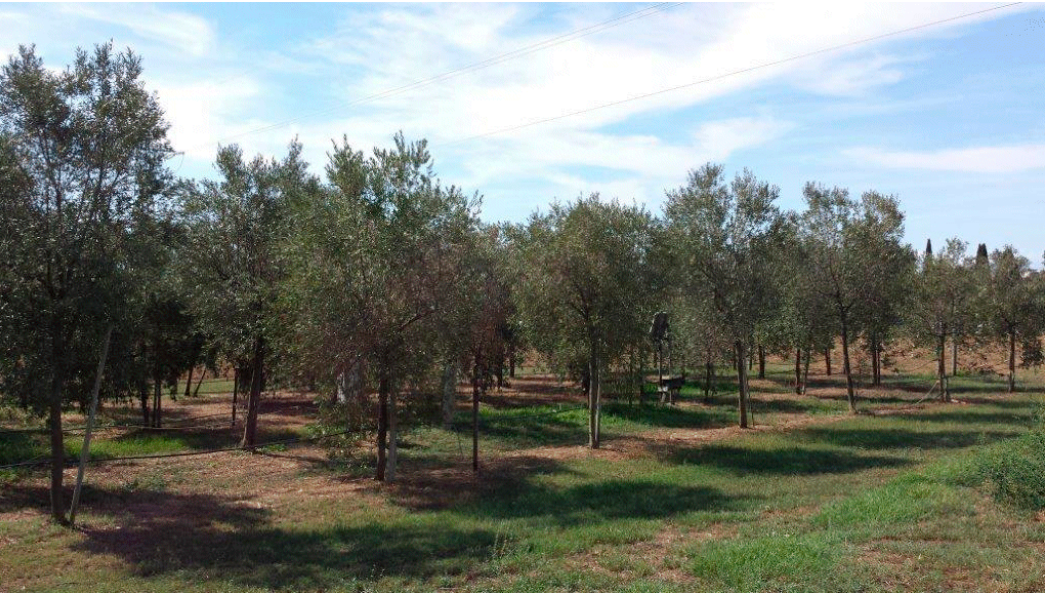
Figure 2. Experimental olive orchard.